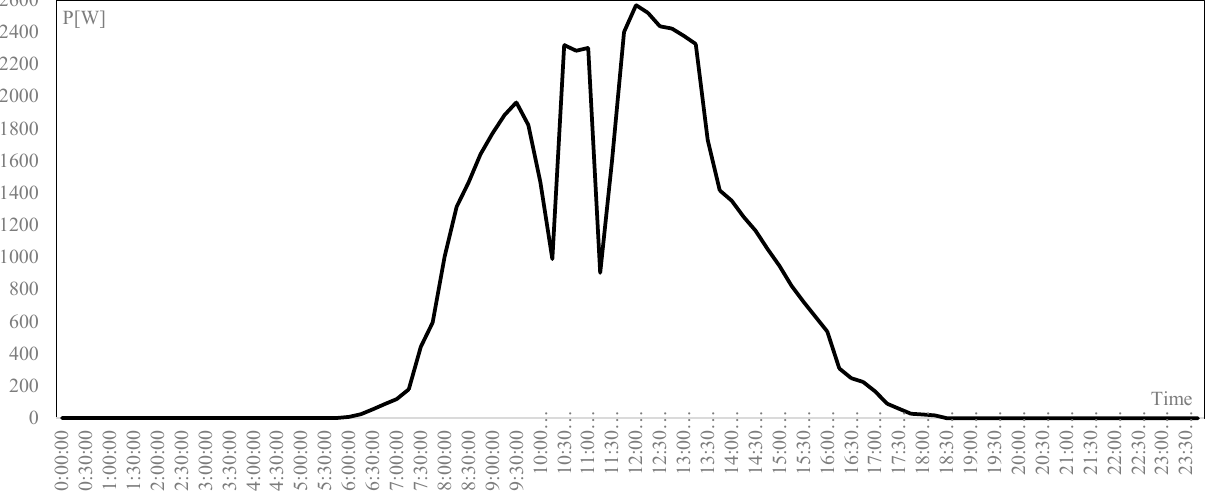
Figure 11. PV power production.